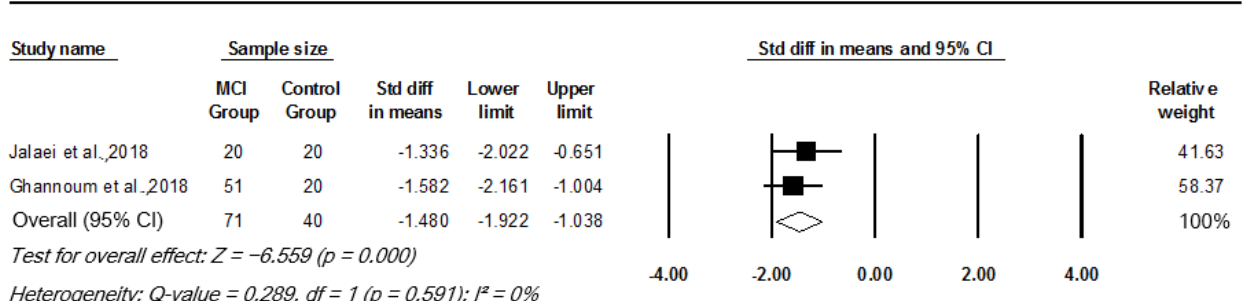
Figure 7. Forest plot of standard mean difference and overall (pooled) estimate of studies investi- gating synthetic sentence identification-ipsilateral competing message (SSI-ICM) test. ( A ) Analysis of SSI-ICM between the mild cognitive impairment (MCI) group and the control group; ( B ) analysis of SSI-ICM between the Alzheimer’s disease (AD) group and the control group. Notes: Z= Z score; I 2 = percentage of heterogeneity; Q-value = Cochrane’s Q; df = degrees of freedom. The horizontal